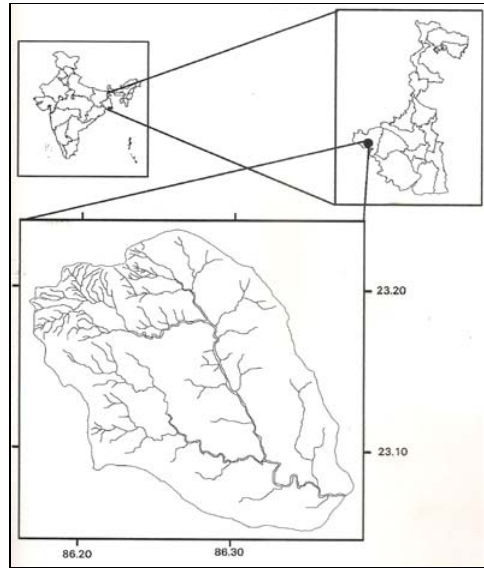
Figure 1. Location map of the study